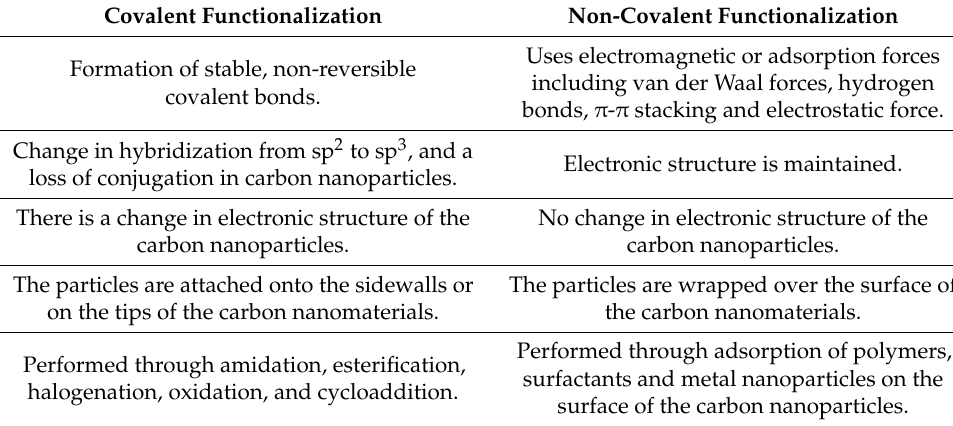
Table 5. Difference between covalent and non-covalent functionalization. Covalent Functionalization Non-Covalent Functionalization Formation of stable, non-reversible covalent